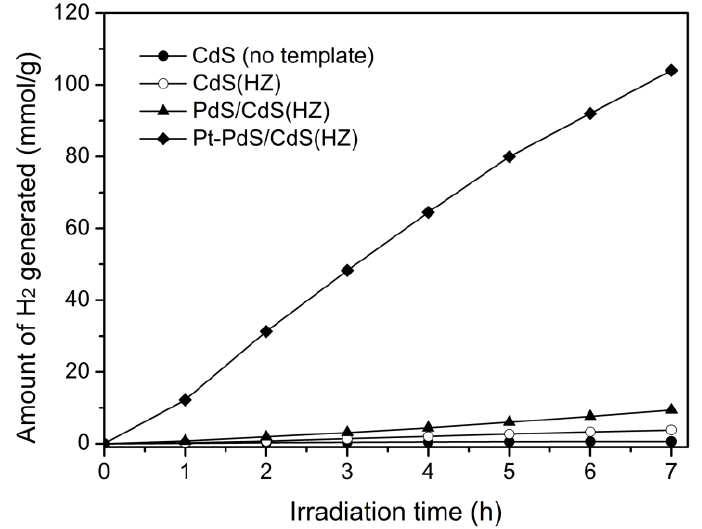
Figure 6. Photocatalytic H 2 production over CdS, CdS(HZ), PdS/CdS(HZ) and Pt-PdS/CdS(HZ) under visible-light irradiation.